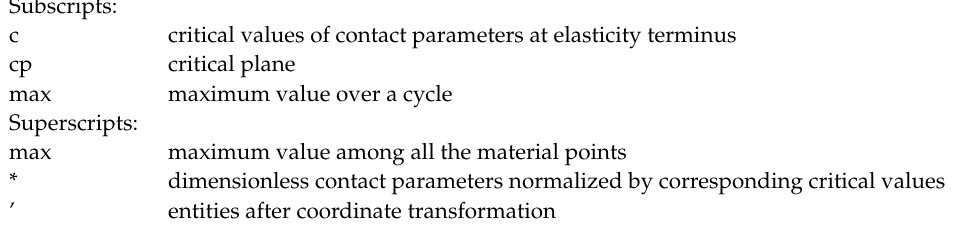
Table A1. The maximum errors of stress components obtained from the elastic FE model.